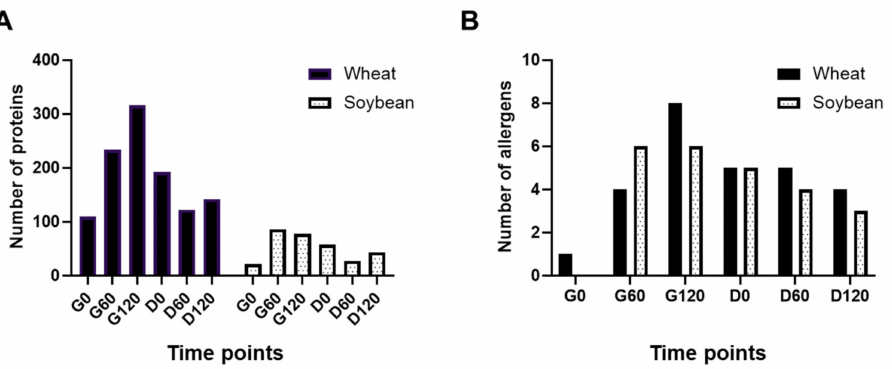
Figure 4. Identification of wheat and soy proteins by mass spectrometry analysis of the soluble fraction of in vitro gastric (G) and duodenal (D) digestion samples. Filled bars—wheat; dotted bars—soy. ( A ) Total number of proteins identified by PEAKS with at least one unique peptide and FDR ≤ 1%. ( B ) Allergen isoforms were identified using the Aller-wheat and Aller-soy sequence databases. Digestion time points are as described in Figure